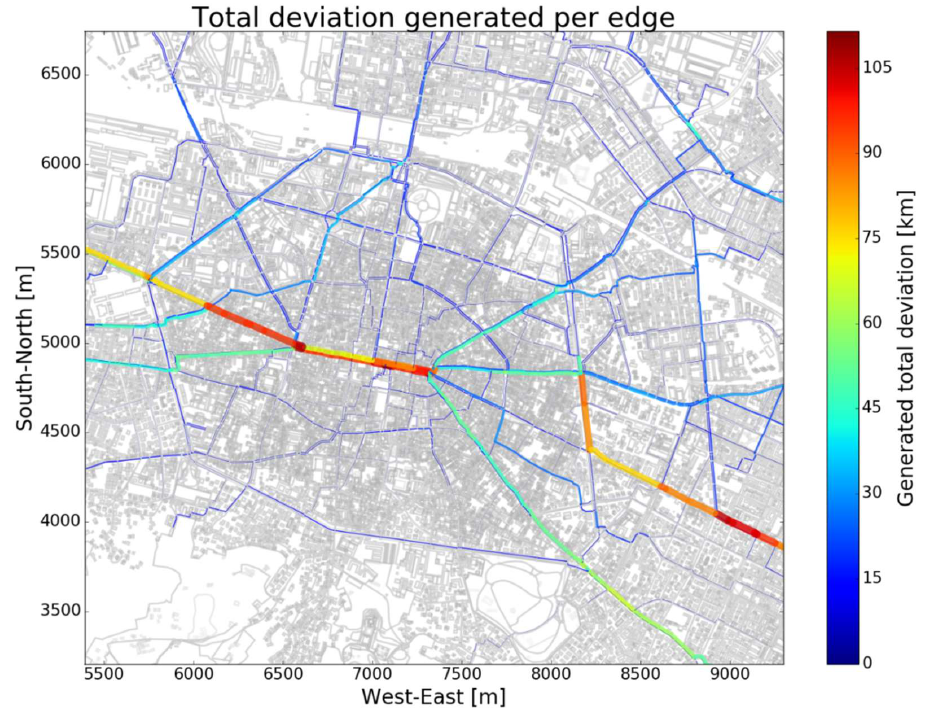
Figure 10. Total deviation metric determined for the central part of Bologna network.